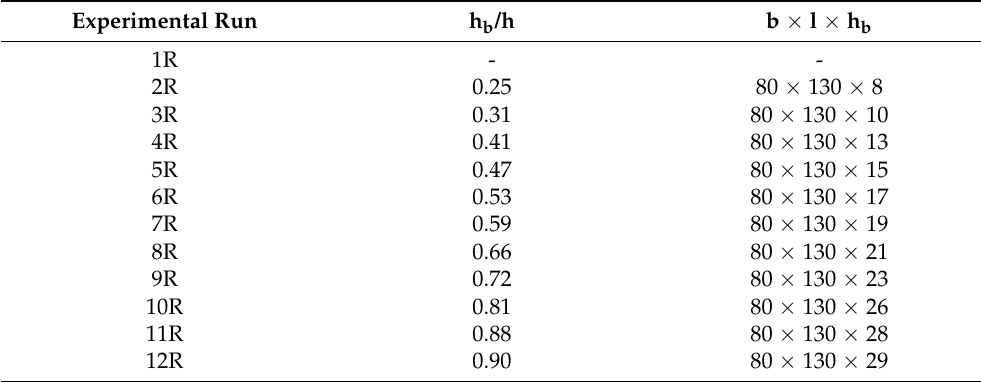
Table 2. Details of the experimental runs performed in this study: l (cm), b (cm). and h b (cm) are the major and the minor dimension, and the height from the flume bed of the emerging sand bar model, respectively, while h b /h is the submergence